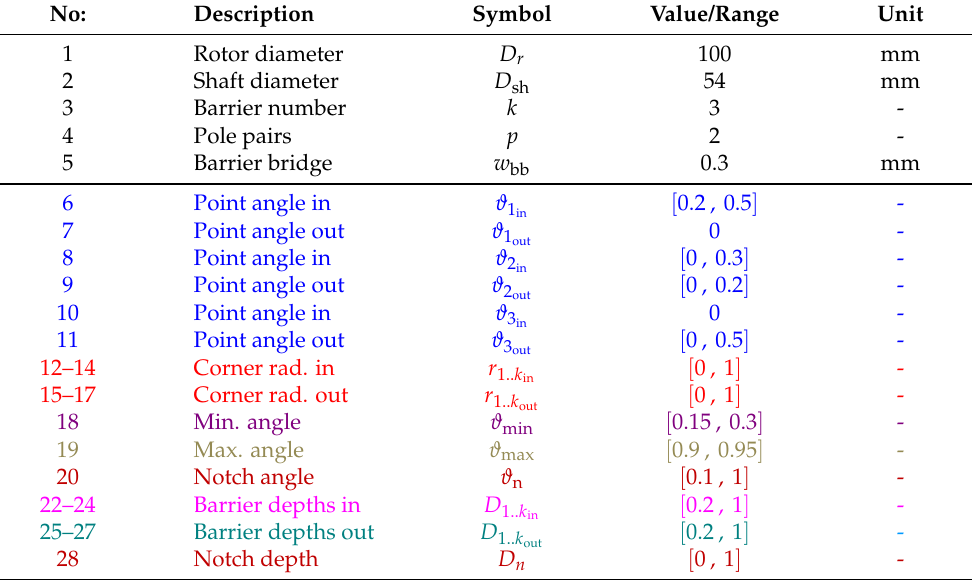
Table 1. Example list of design parameters. Color coding is according to Figure 4 variables.